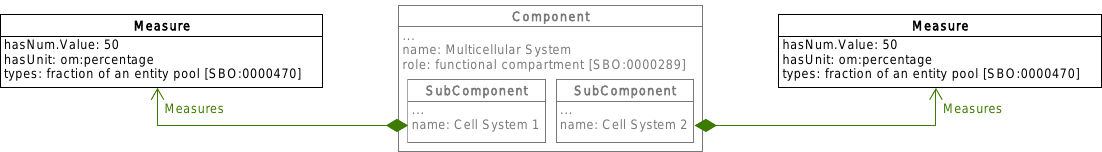
Figure 24: Annotating class instances with cellular proportions. Instances of the Measure class are used to capture the percentage of each cell type present in the multicellular system